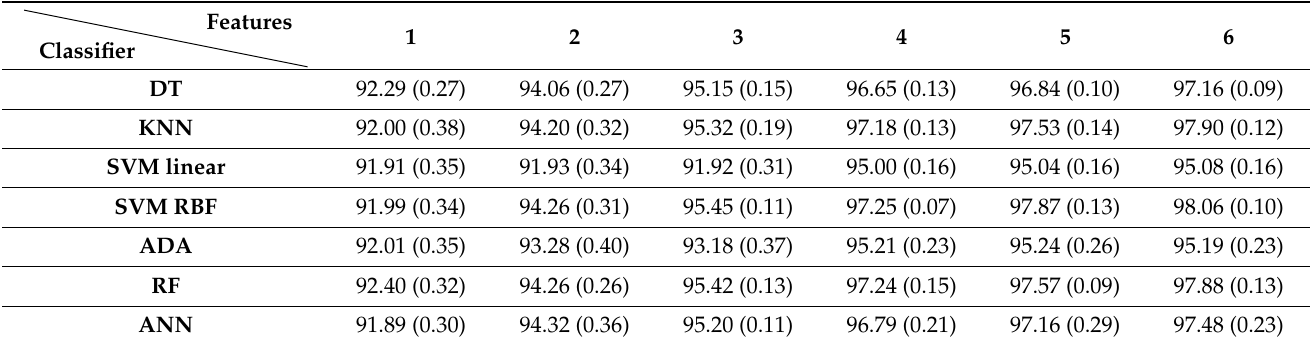
Table 4. Average values and standard deviations of accuracy in 5-fold cross-validation in 60 s recordings (in